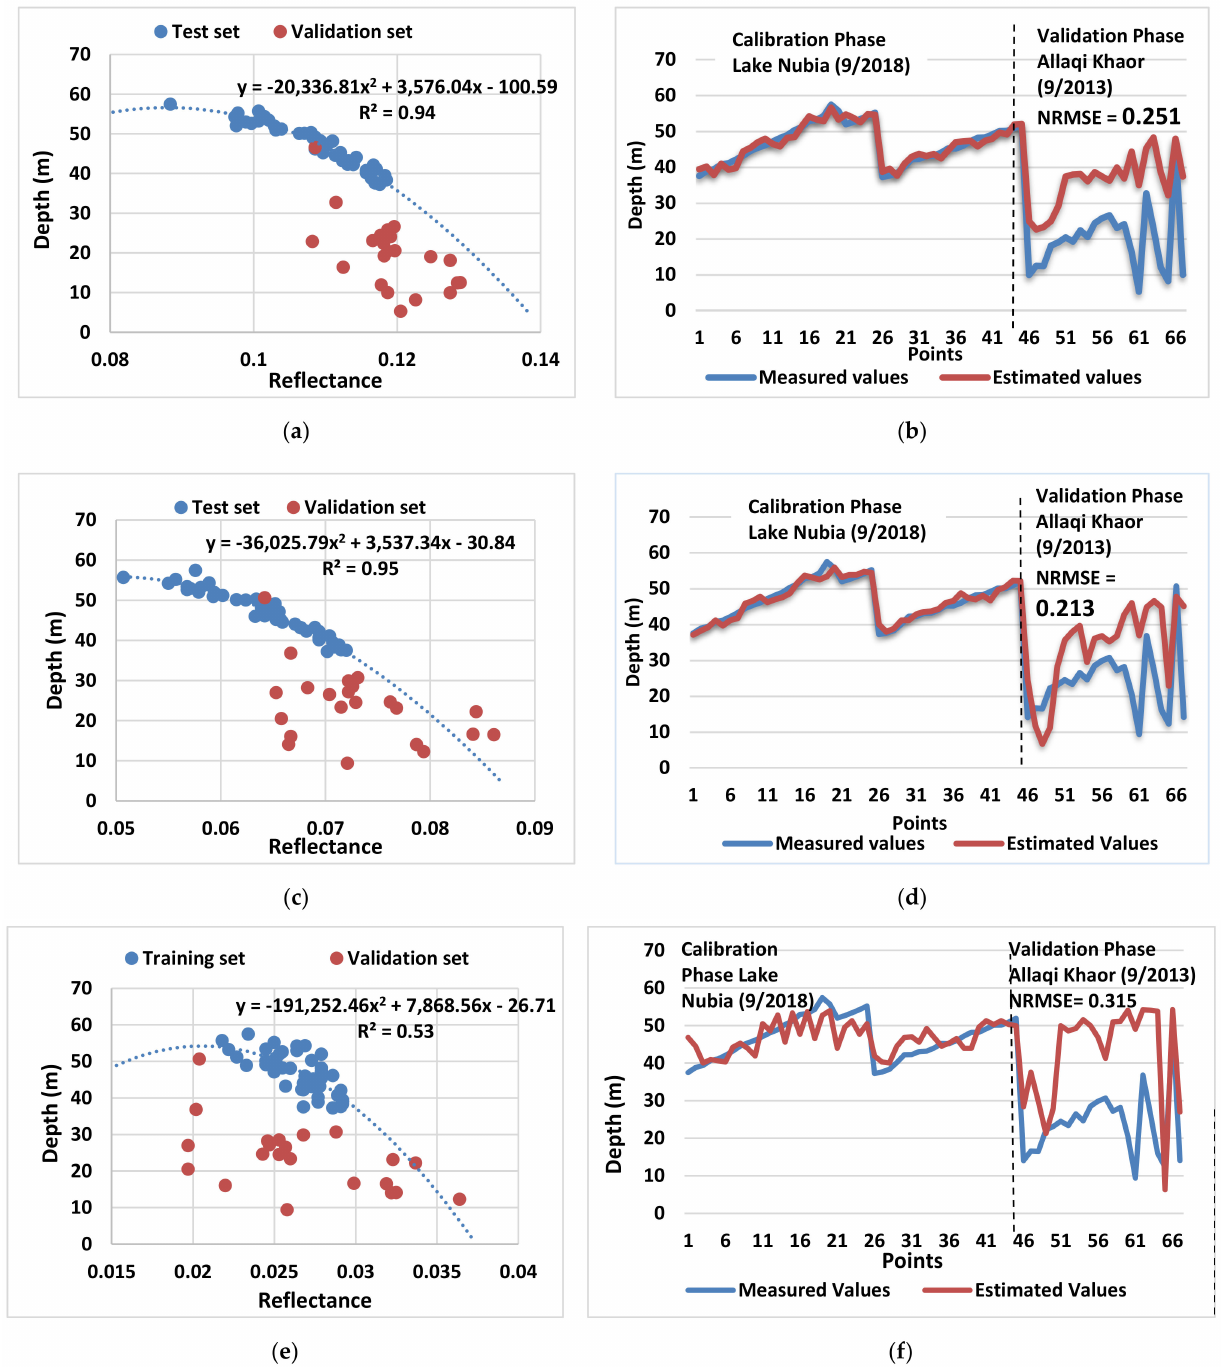
Figure 9. Regression model of SLSTR reflectance and depth; ( a ) In situ measured depth and reflectance of S1 (Green band) relationship, and result of correlation and polynomial equation ( b ) Model results validation of S1 (Green band), NRMSE between estimated and in situ measured depth ( c ) In situ measured depth and reflectance of S2 (Red band) relationship, and results of correlation and poly- nomial equation ( d ) Model results validation of S2 (Red band), NRMSE between estimated and in situ measured depth ( e ) In situ measured depth and Reflectance of S3 (NIR band) relationship, and result of correlation and polynomial equation ( f ) Model results’ validation of S3 (NIR band), NRMSE between estimated and in situ measured